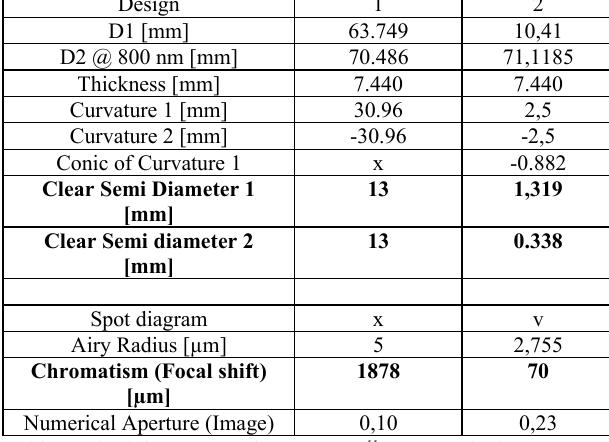
Table 2: Thorlabs-LB4879, f=35 mm, 𝛷 1 ′′ UV Fused Silica Bi- Convex Lens. Design 1: starting design. Design 2: constraint on diameter of optics with